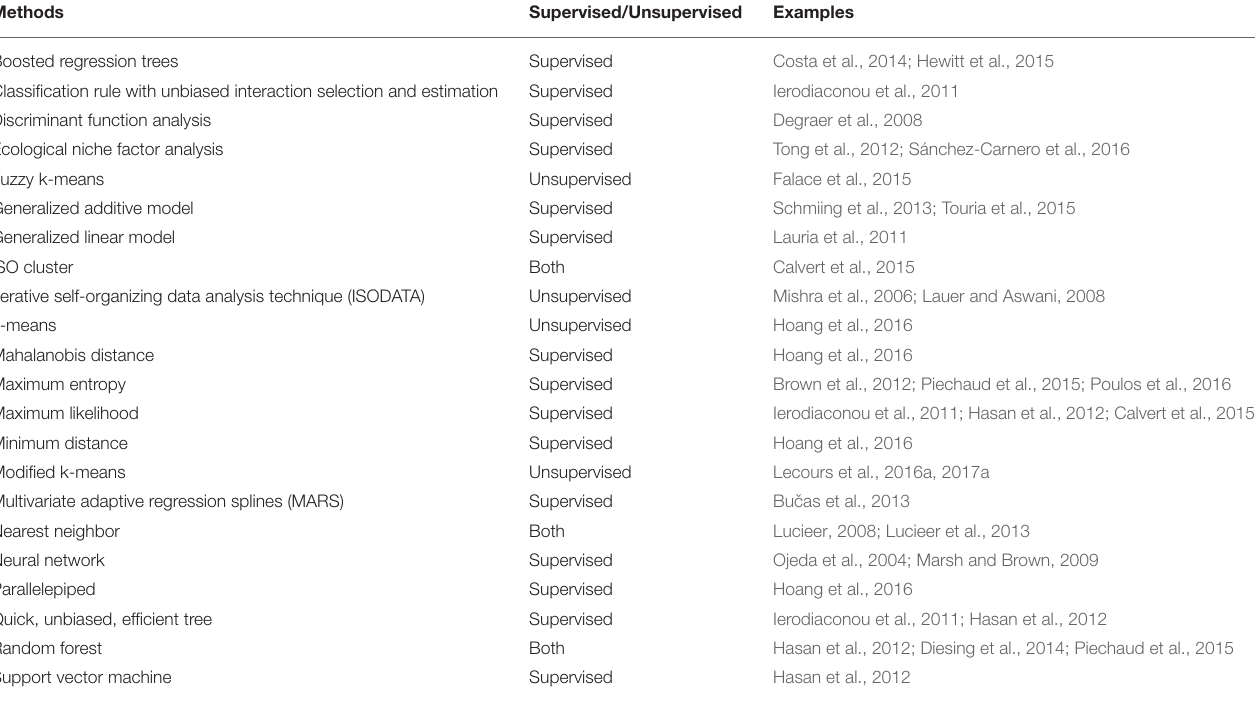
TABLE 3 | Examples of classification methods used in marine habitat mapping and species distribution modeling, with examples.